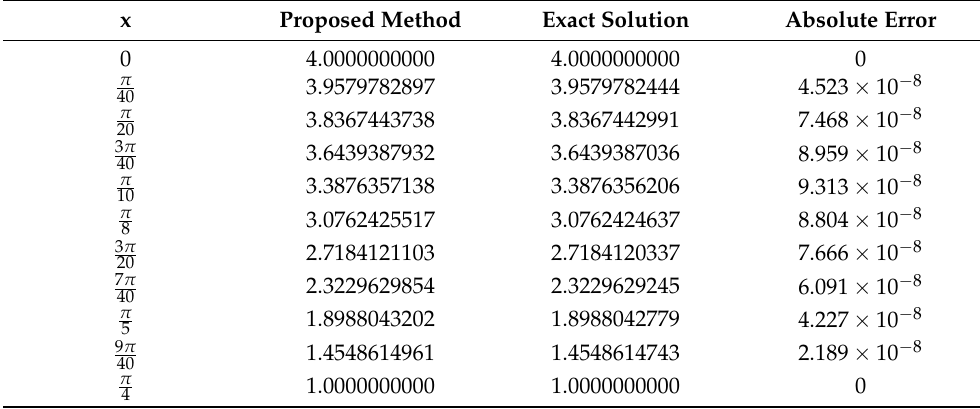
Table 8. Absolute errors for Problem 4 at h =